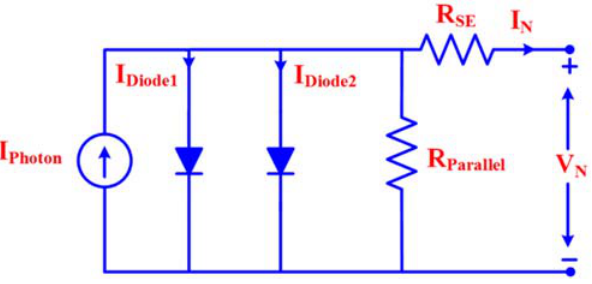
Figure 2. Equivalent circuit model of a PV cell with double diodes and a series and parallel resistance.